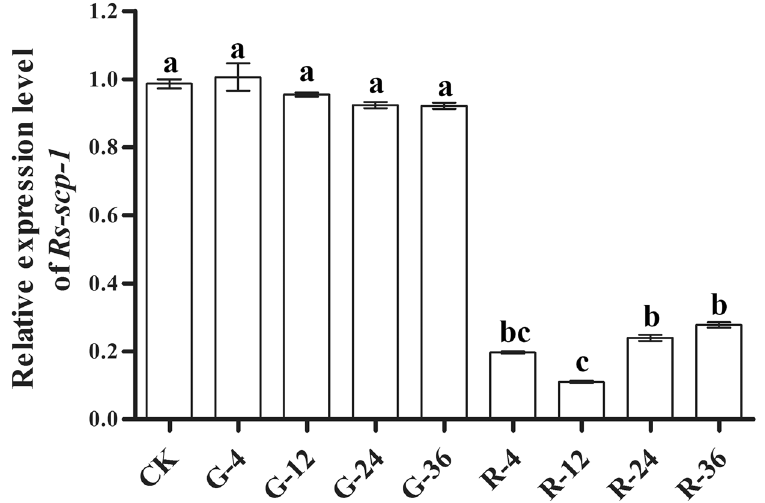
Figure 6. Expression of Rs - scp - 1 in Radopholus similis under different treatments. CK: blank control; G-4, G-12, G-24, and G-36: R . similis treated with egfp dsRNA for 4, 12, 24 and 36 h, respectively; R-4, R-12, R-24, and R-36: R . similis treated with Rs - scp - 1 dsRNA for 4, 12, 24 and 36 h, respectively. Bars indicate the standard error of the mean (n = 3), and different letters indicate significant differences (p < 0.05) between treatments.